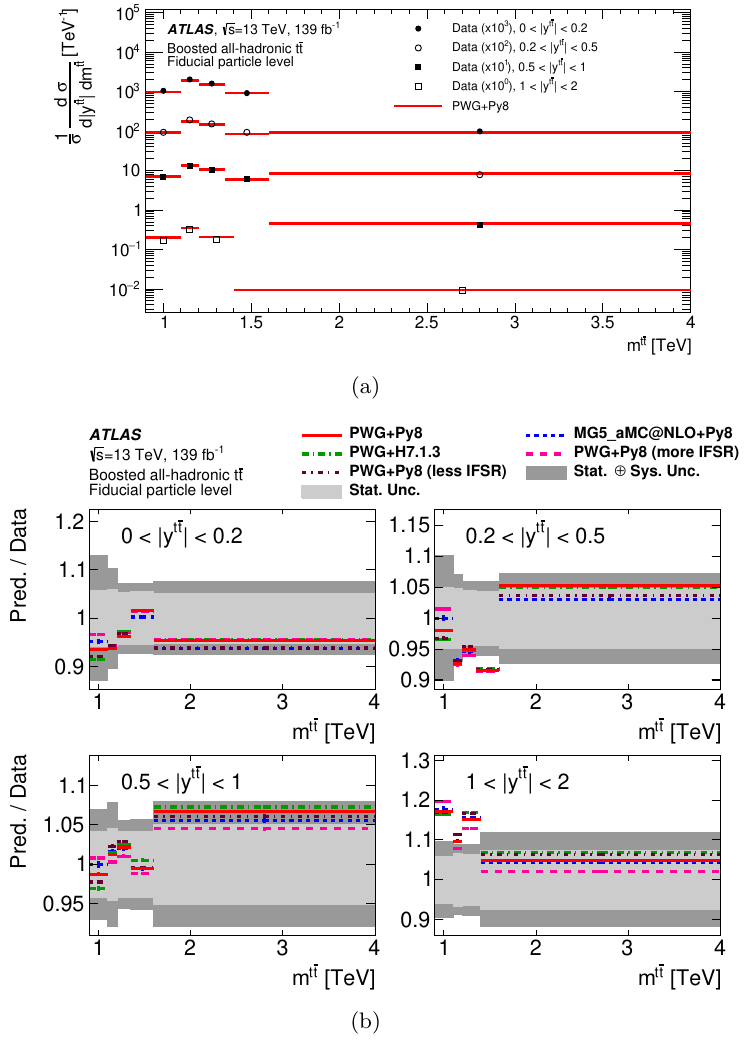
Figure 43 . (a) Normalized particle-level fiducial phase-space double-differential cross-sections as a function of the absolute value of the rapidity and the mass of the t ¯ t final state, compared with the Powheg+Pythia 8 calculation. Data points are placed at the centre of each bin and the Powheg+Pythia 8 calculation is indicated by solid lines. The measurement and the prediction are normalized by the factors shown in parentheses to aid visibility. (b) The ratios of various MC calculations to the normalized particle-level fiducial phase-space differential cross-sections. The dark and light grey bands indicate the total uncertainty and the statistical uncertainty, respectively, of the data in each